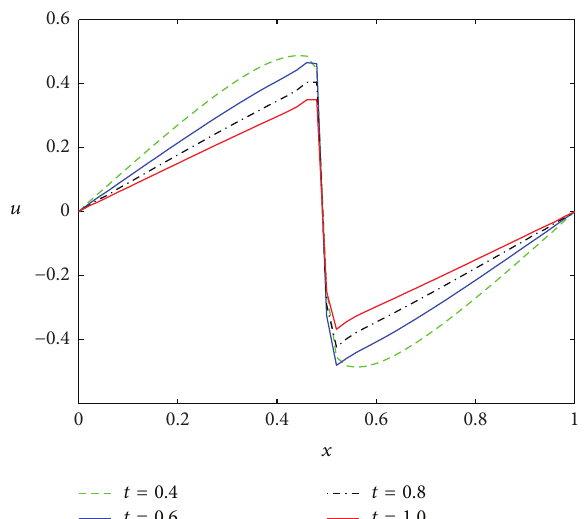
Figure 12: Solutions 𝑢(𝑥,𝑥,𝑡) of the VMEFG with low-pass filter at different times for Re = 10 4